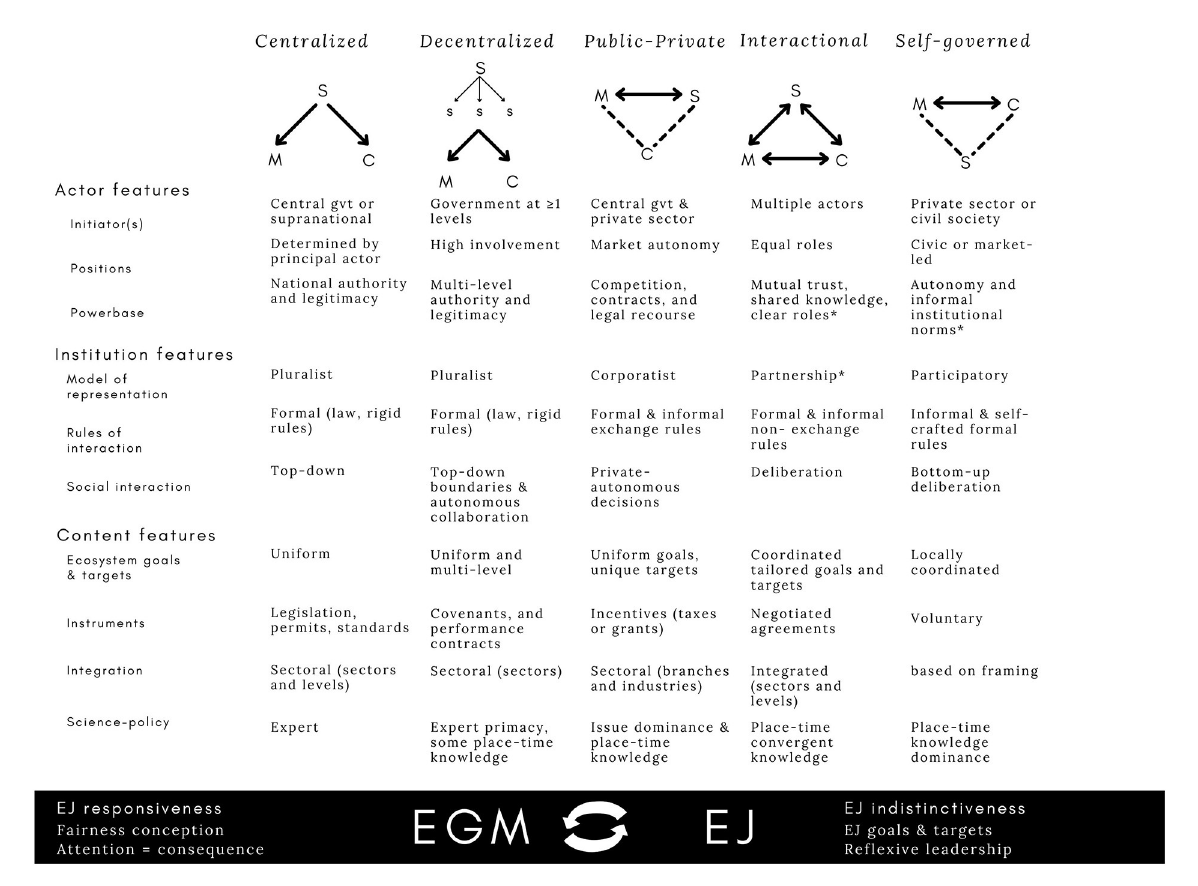
FIGURE1 Environmental governance modes—EJ extension (modified by the authors from Driessen et al.,